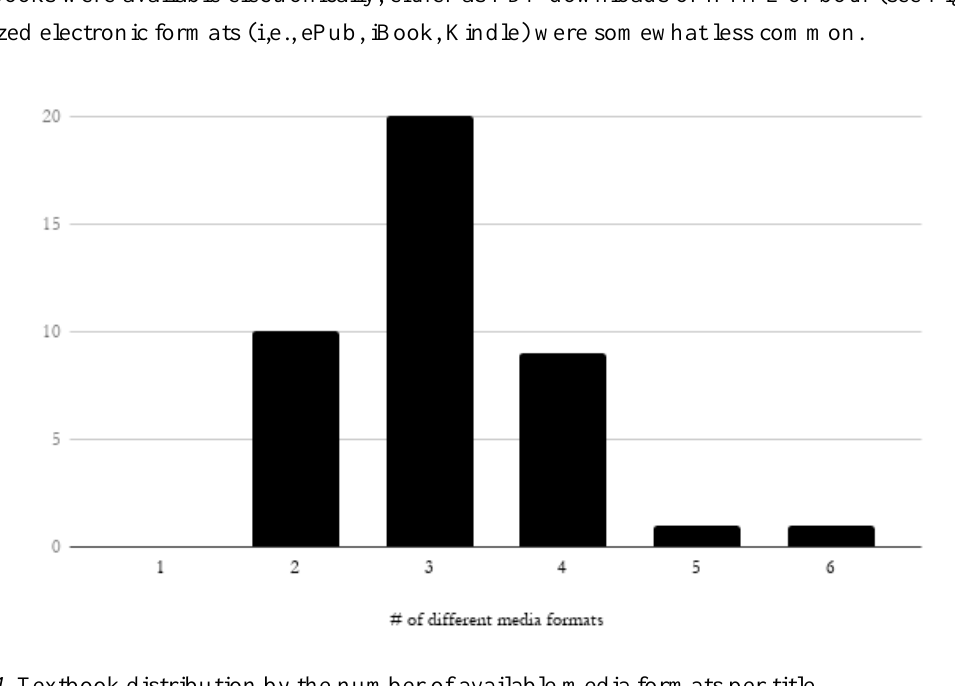
Figure 4. Textbook distribution by the number of available media formats per